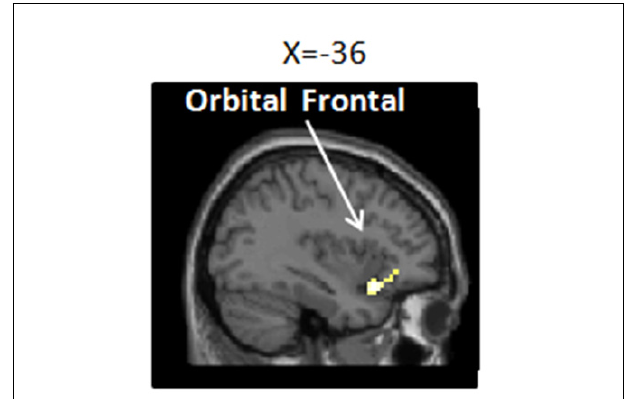
FIGURE 4 | Brain network of the placebo effect of (PP+PN) − (CP+CN; i.e., placebo condition vs. no-placebo control condition, regardless of pain or no pain pictures.). Enhanced activation in the placebo treatment was found in the left inferior orbital frontal gyrus ( − 36, 18, − 15), p (unc.) < 0.001, two continuous or more